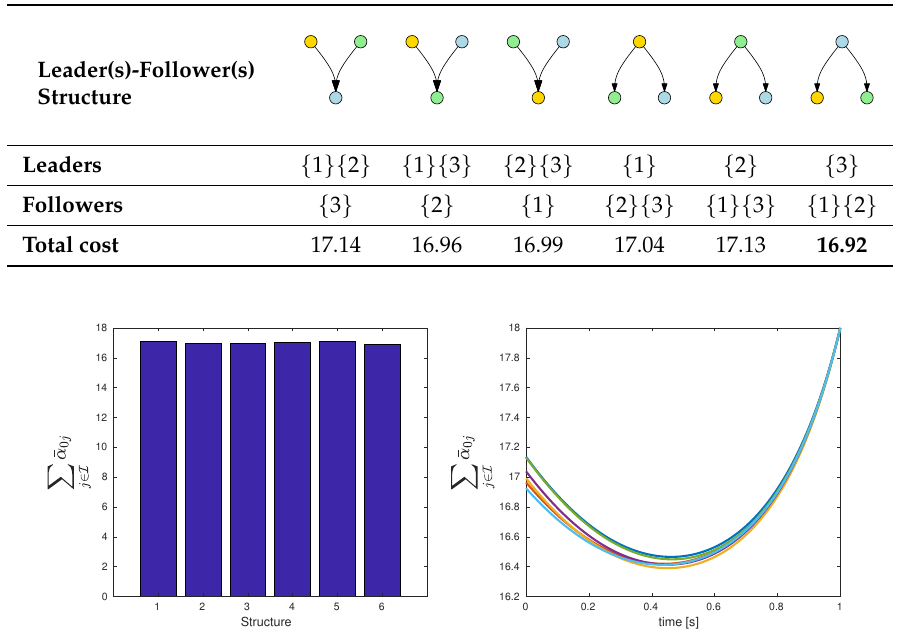
Figure 7. Evolution of the sum of differential equations and the corresponding total cost for the heterogeneous